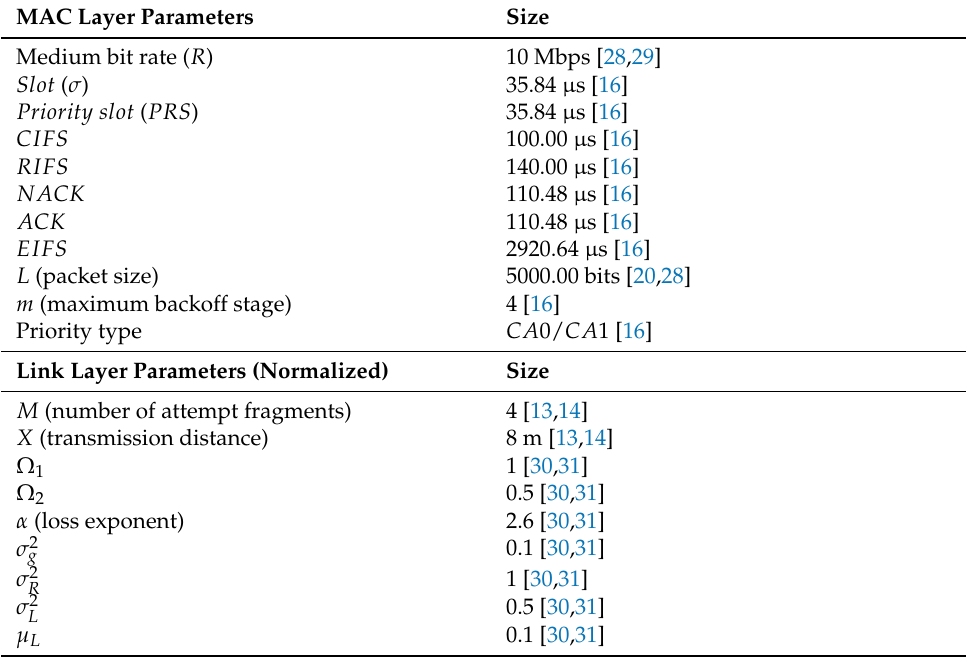
Table 4. System parameters of reliable PLC